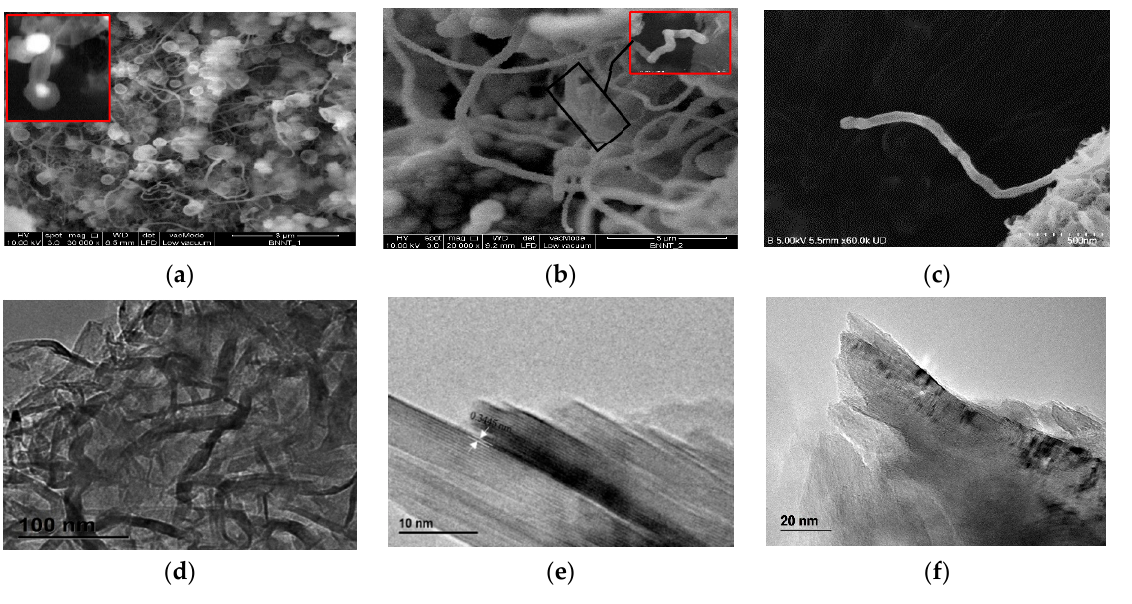
Figure 4. SEM images of ( a ) r-BNNTs (inset: white colour spot inside nanotubes represents the catalyst substance in nanotubes); ( b ) f-BNNTs (inset: high magnification of quasi-cylindrical nanotubes); ( c ) bamboo-like structure of f-BNNTs; TEM images of ( d ) r-BNNTs at low magnification; ( e ) r-BNNTs; ( f ) f-BNNTs.